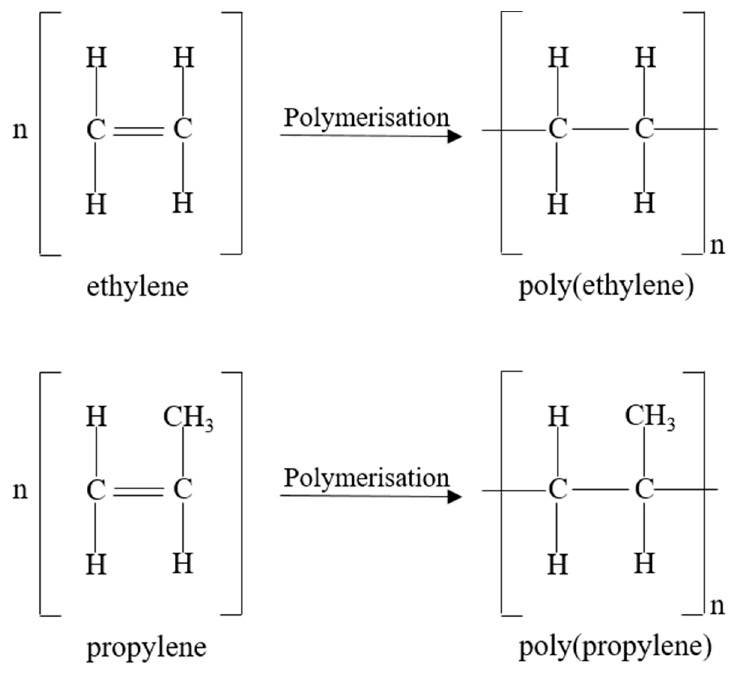
Figure 4. Ethylene and propylene monomers for the formation of PE and PP, respectively.